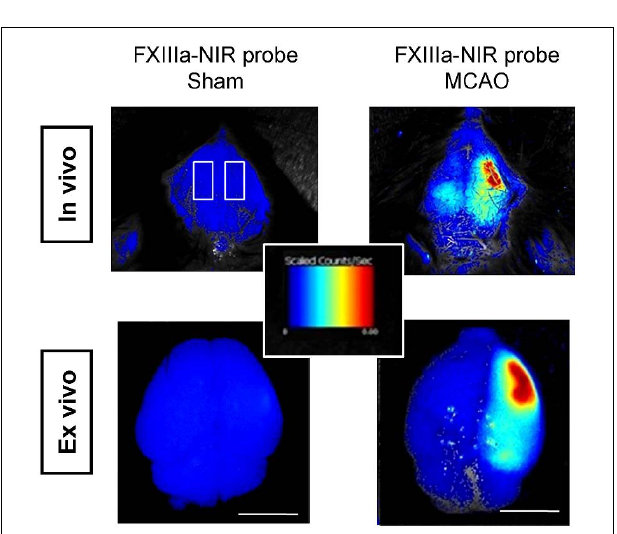
FIGURE 3 | In vivo FLI of thromboembolic-stroke. Fibrin deposition is visualized with a near-infrared probe against the activated coagulation factor XIII (FXIIIa; A15) in a thromboembolic model of stroke. Scale bar 5 mm. Images adapted with permission from Zhang etal.